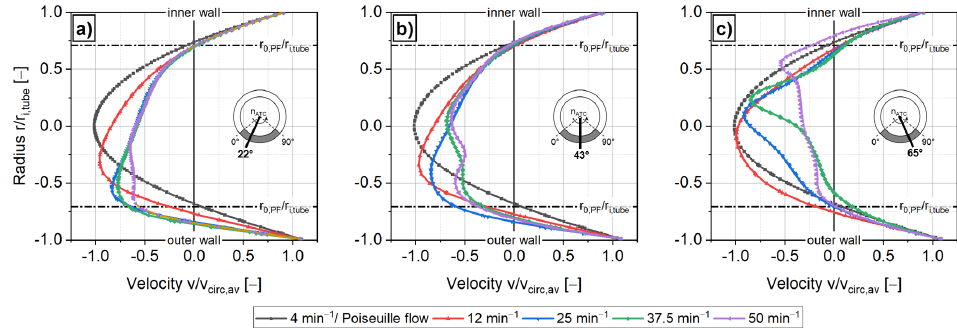
Figure 8. Velocity profiles for different rotational speeds n ATC at filling degree (cid:101) = 0.25 for angular positions ( a ) 22 ◦ , ( b ) 43 ◦ , and ( c ) 65 ◦